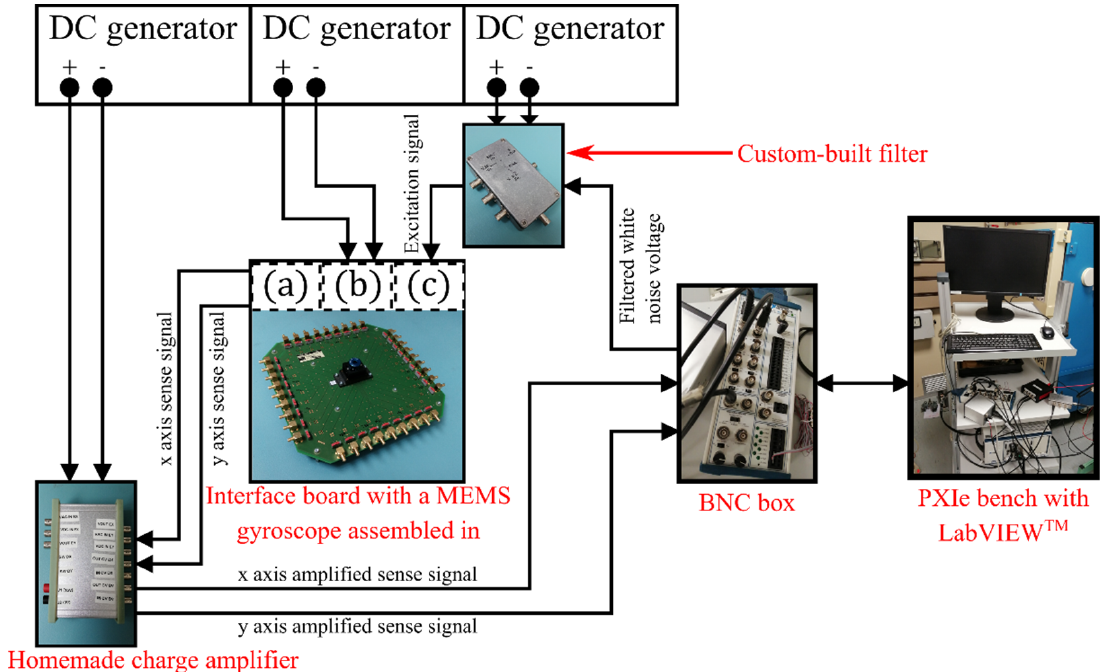
Figure 7. Scheme of the bench developed to measure the quadrature error: (a) contact with the x axis and y axis sense electrodes, (b) contact with the frequency mismatch compensation electrodes, and (c) contact with the x axis drive electrode(s).